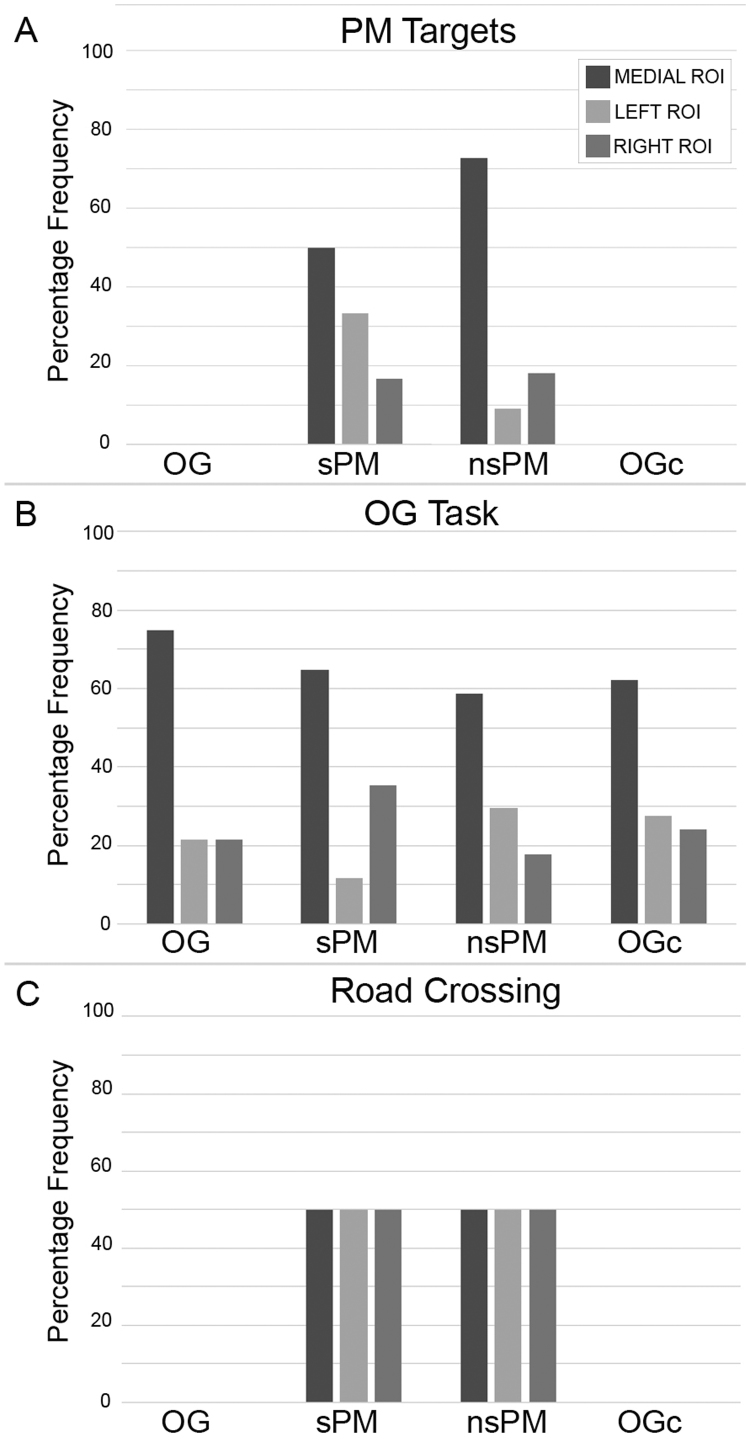
ROI analysis results. MEDIAL, LEFT and RIGHT ROIs percentage involvement in the PM Targets processing, OG Task and Road Crossing across the four experimental conditions are shown in panel A, B and C, respectively.